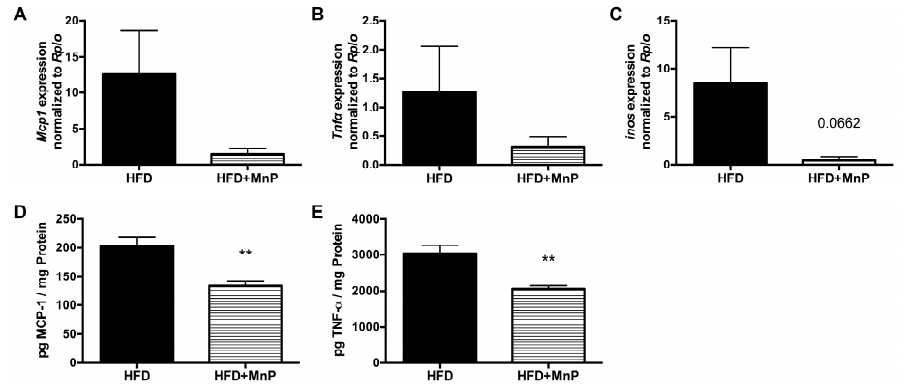
Figure 7. Redox modulation and NF- κ B inhibition have anti-inflammation effects in the liver. After 12 weeks of HFD feeding, hepatic gene expression was measured by qRT-PCR for ( A ) MCP1, ( B ) TNF α , and ( C ) inducible nitric oxide synthase (iNOS), with or without MnP treatment. Data are displayed as mean ± SEM, n = 5 mice per group. After 12 weeks of HFD feeding, hepatic protein expression was measured by ELISA, for ( D ) MCP-1 and ( E ) TNF- α , with or without MnP treatment. Cytokine concentrations were normalized to protein concentration to yield pg of cytokine per mg of protein. Data are displayed as mean ± SD, n = 5 mice per group. Significance was calculated by t -tests. ** indicates p ≤ 0.01.